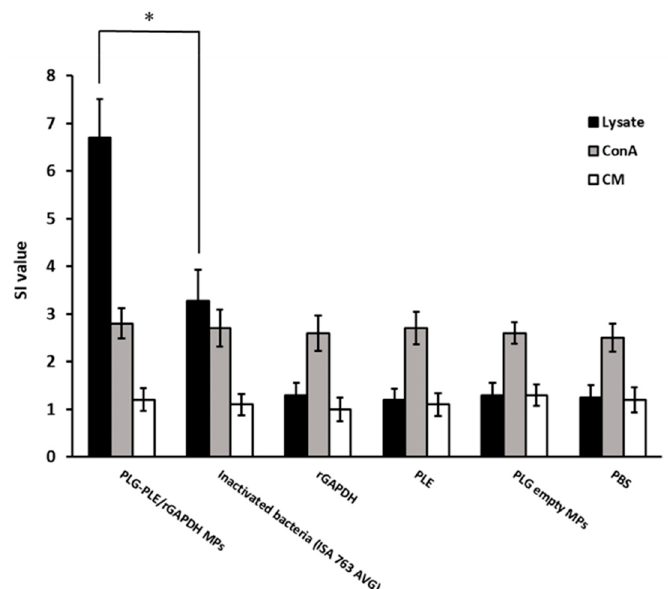
Figure 3. Grouper lymphocyte proliferation to V. harveyi lysate. Six groups of grouper were peritoneally vaccinated with a single shot of PLG-PLE/rGAPDH MPs, a single shot of inactivated bacteria (ISA 763 AVG), a single shot of rGAPDH, a single shot of PLE, a single shot of PLG empty MPs, or a single shot of PBS. Twelve weeks after peritoneal vaccination, proliferative responses of lymphocytes stimulated with V. harveyi lysate ( ∎ ), Con A ( ∎ ), or culture medium (CM) ( □ ) were assessed and expressed as stimulation index (SI) values. Results were presented as the mean of SI values ± standard deviation (SD). * A significant difference ( p < 0.05) exists when comparing the PLG-PLE/rGAPDH MPs group to the inactivated bacteria (ISA 763 AVG) group.